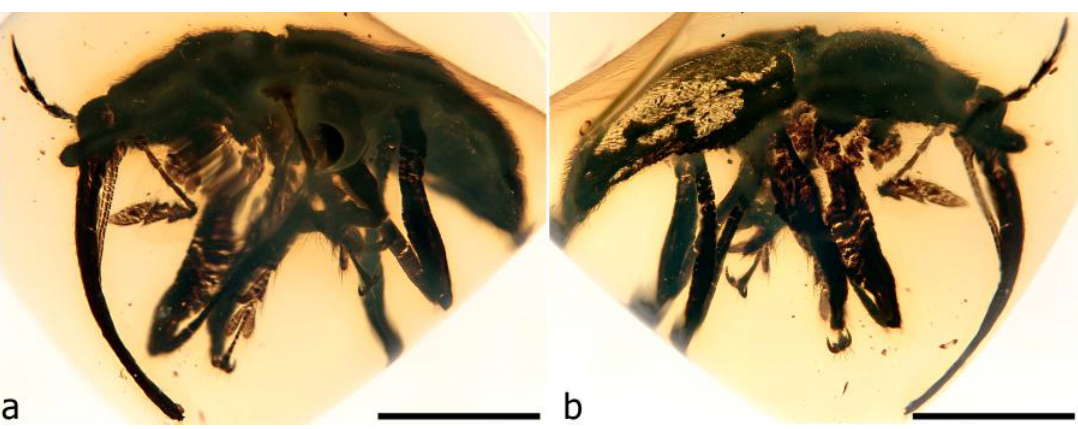
Figure 64. Mekorhamphus sp. Habitus, left lateral ( a ); habitus, right lateral ( b ). Scale bars: 1.0 mm (a,b). Genus Compsopsarus Clarke & Oberprieler, gen. n.